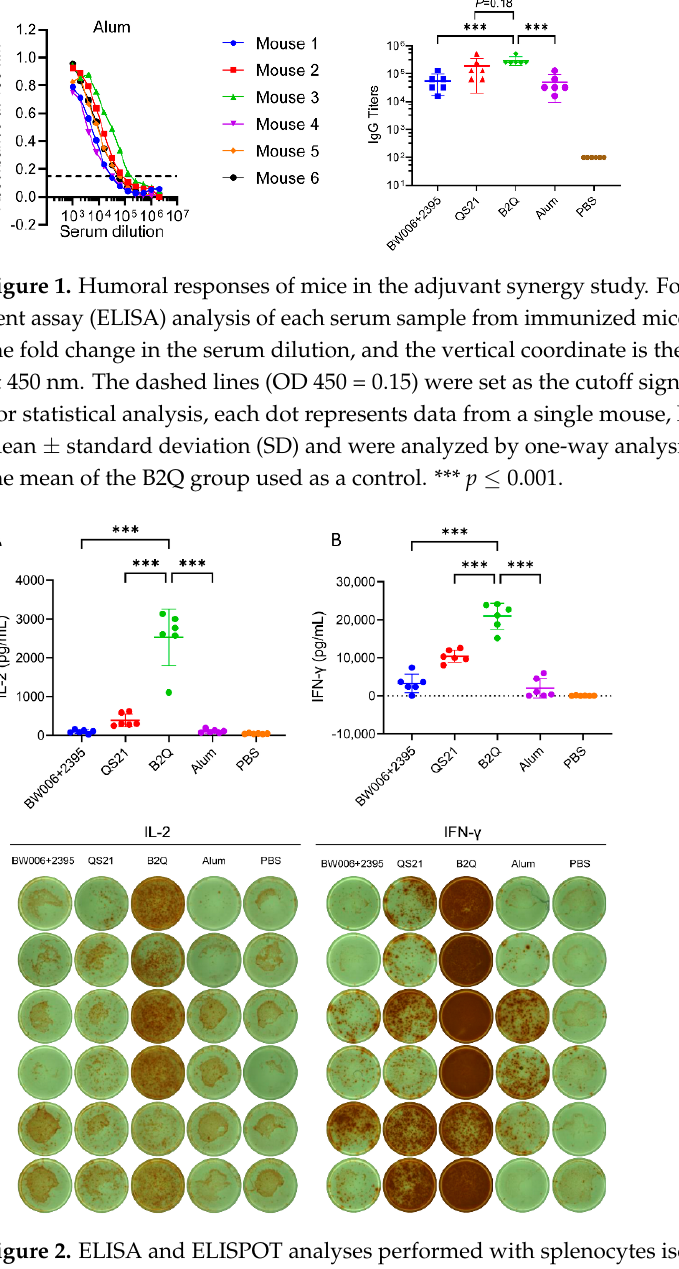
1.6 times greater than that of the QS21 alone-adjuvanted group (0.2013%, p = 0.006). The proportion of IFN- γ -expressing CD4 + T cells after gE stimulation in the B2Q-adjuvanted group was 0.4457%. This level was 9.3 times greater than that of the CpG alone-adjuvanted group (0.04767%, p < 0.001) and 4.3 times greater than that of the QS21 alone-adjuvanted group (0.1025%, p < 0.001). In contrast, no VZV-gE-specific CD8 + T cells were induced after immunization with any of the designed vaccines, with the IL-2- and IFN- γ -producing CD8 + T-cell proportions in the vaccinated groups being comparable to those in the PBS- immunized control group by flow cytometric analysis (Figure 3B).